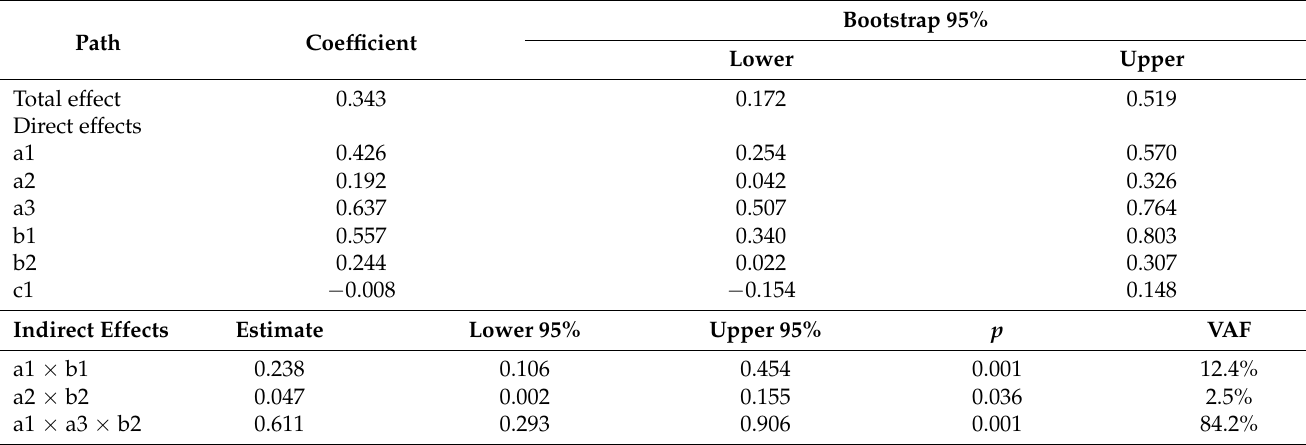
Table 5. Significance of direct and indirect effects.